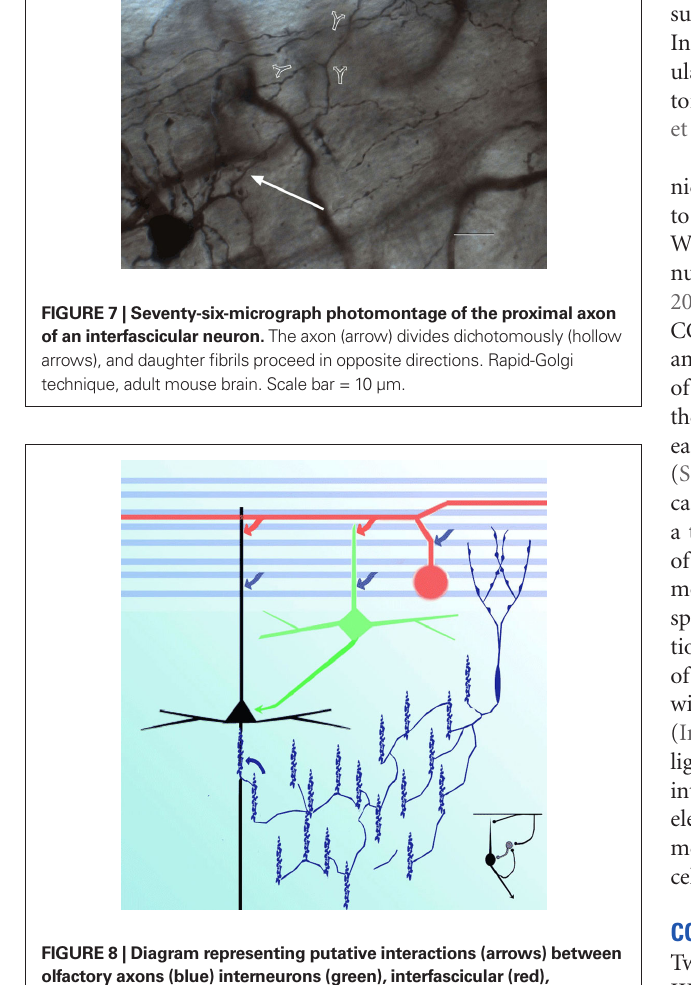
Figure 8 | Diagram representing putative interactions (arrows) between olfactory axons (blue) interneurons (green), interfascicular (red), chandelier (deep blue), and pyramidal (black)